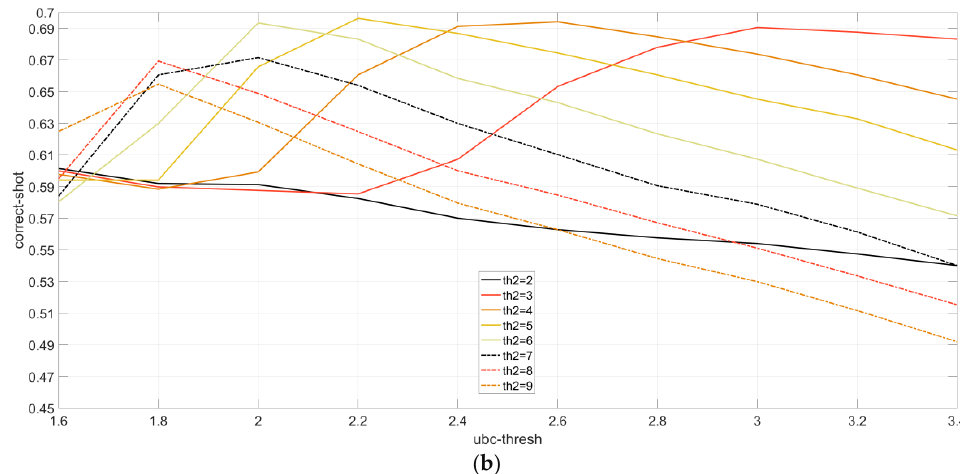
Figure 19. The experimental results by using the SURF method. ( a ) Video searching; ( b ) Shot searching. Results of Image-Query-Based Video Searching Experiments with Transformations